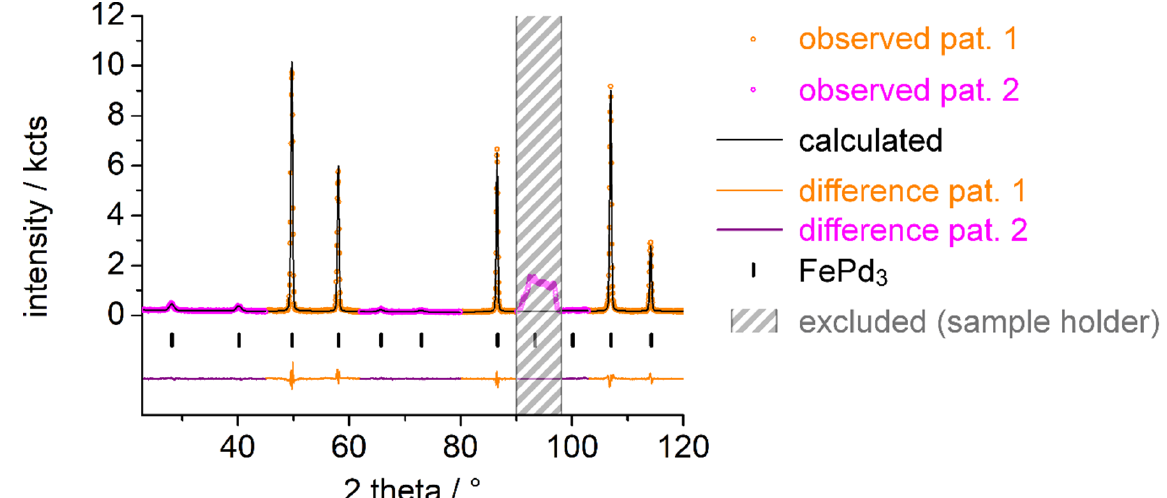
Figure A11. Rietveld refinement of the crystal structure of FePd 3 D 0.017(8) (for details, see fourth row in Tables A6 and A7) based on neutron powder diffraction data (NUMOR 131642 [21], λ = 186.80(2) pm, D20 ILL, Grenoble) in a single-crystal sapphire cell at 296(1) K and 2.00(1) MPa deuterium pressure using FullProf [24].